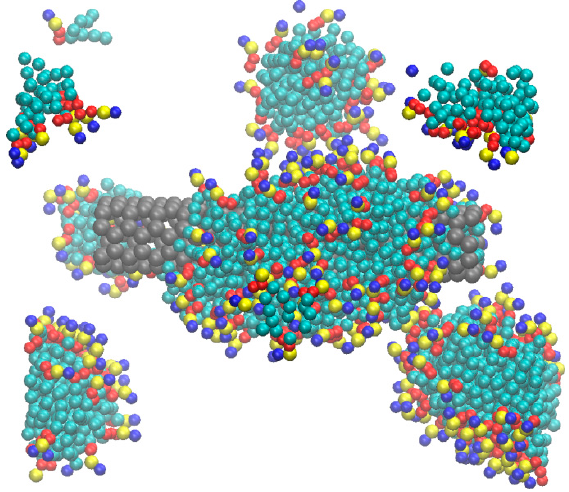
Figure 2. Snapshot of the simulation box, indicating clustering of DPPC molecules in the solution. Both free DPPC molecules (monomers) and clusters adsorb on the surface of CNT (14, 14). Water molecules are not shown.